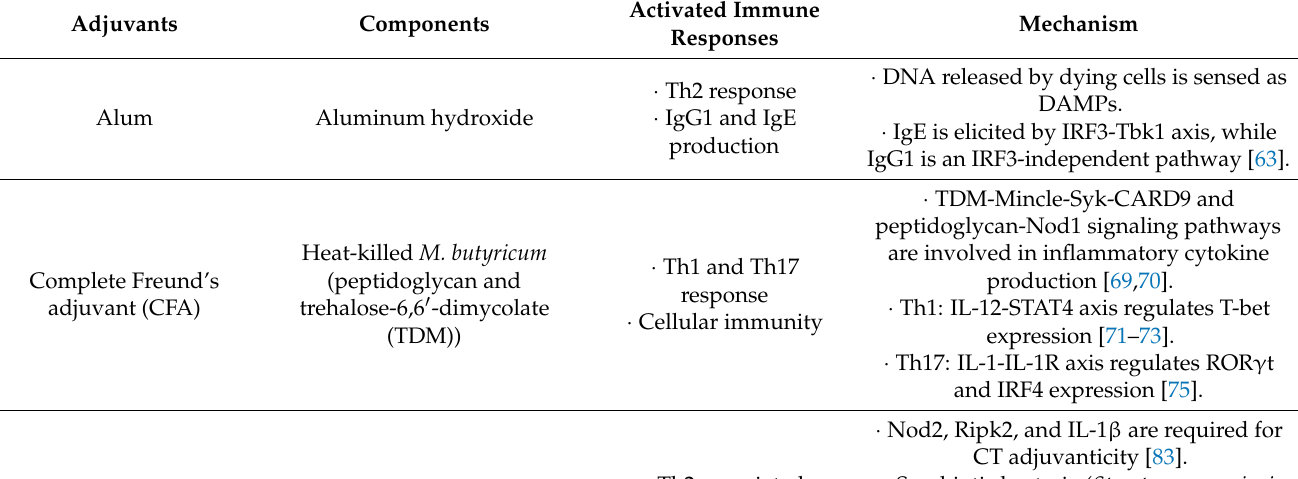
Table 2. The different types of adjuvants and their immunological